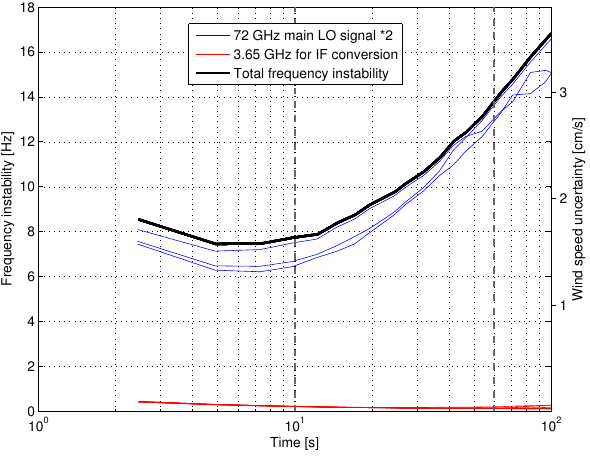
Figure 3. Influence of the fluctuations and drifts of the frequency sources on the total frequency uncertainty of the measured signal. The instability of the 72GHz local oscillator (LO) frequency has to be multiplied by 2 as the subharmonic mixer uses the second har- monic of the LO signal. The grey vertical lines at 10 and 60s mark the minimum integration time per single measurement and the du- ration of one measurement cycle. The second y axis indicates the influence of the instabilities of the frequency sources on the uncer- tainty of the retrieved wind